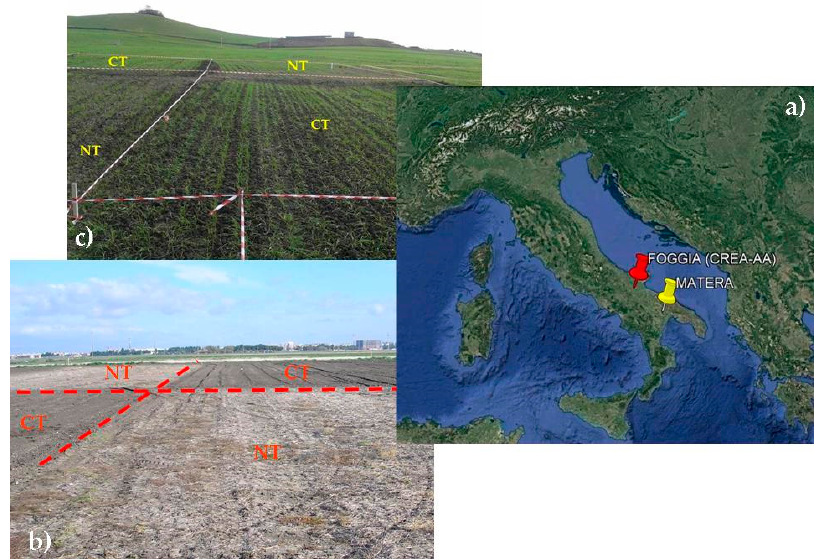
Figure 1. Geographical location of experimental sites ( a ) and details of sampling sites (NT, no-tillage; CT, conventional tillage) of Foggia ( b ) and Matera ( c ).